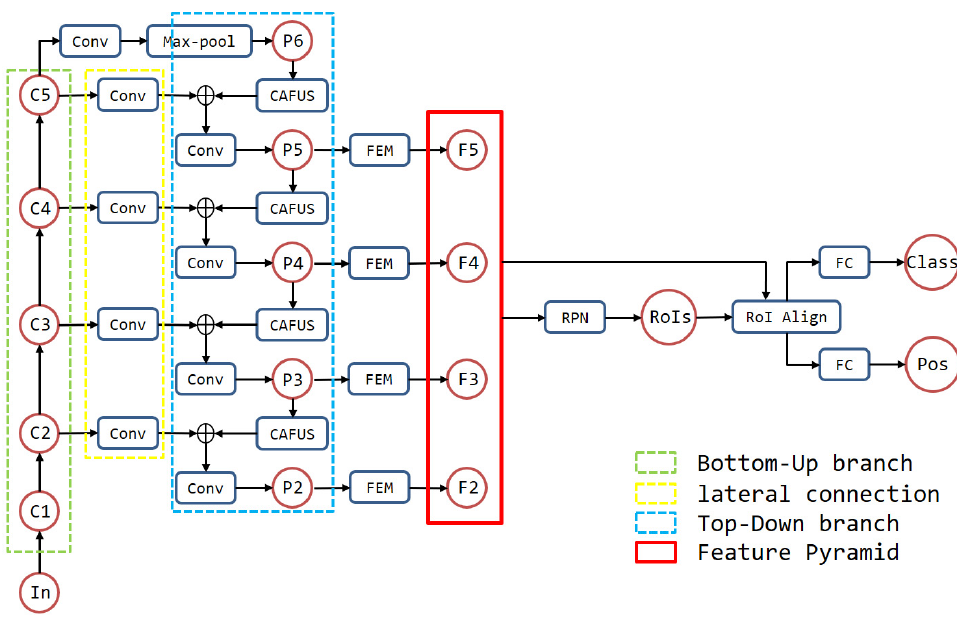
Figure 1. The structure of network proposed in this paper, where the green dashed box represents the bottom-up branch, the yellow dashed box represents the laterally connected branch, the blue dashed box represents the top-down branch, and the red solid box represents the final generated feature map set.